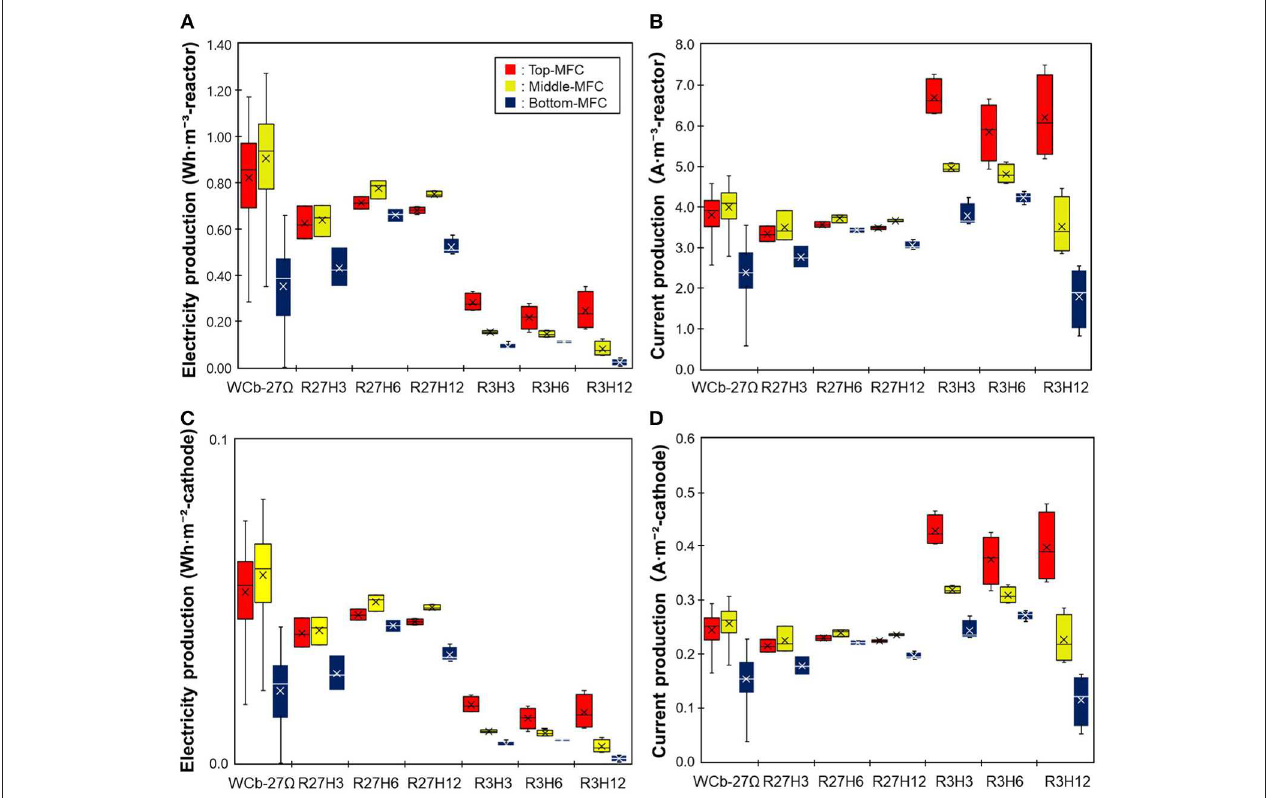
FIGURE 3 | A comparison of the electricity production by the MFCs operated under six different conditions. (A,B) indicate electricity and current production, respectively, normalized by the reactor volume. (C,D) indicate electricity and current production, respectively, normalized by the cathode area.